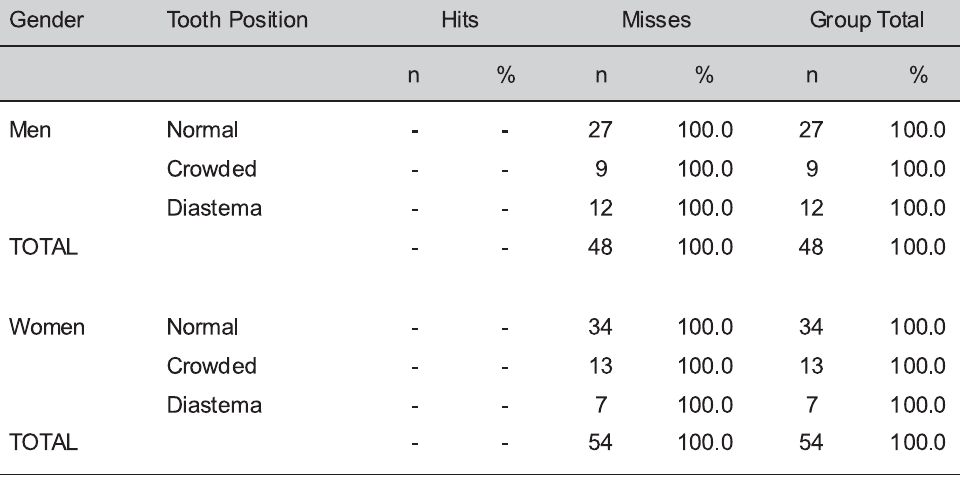
Table 3 - Distribution of hits and misses for normal tooth position, crowded teeth and those